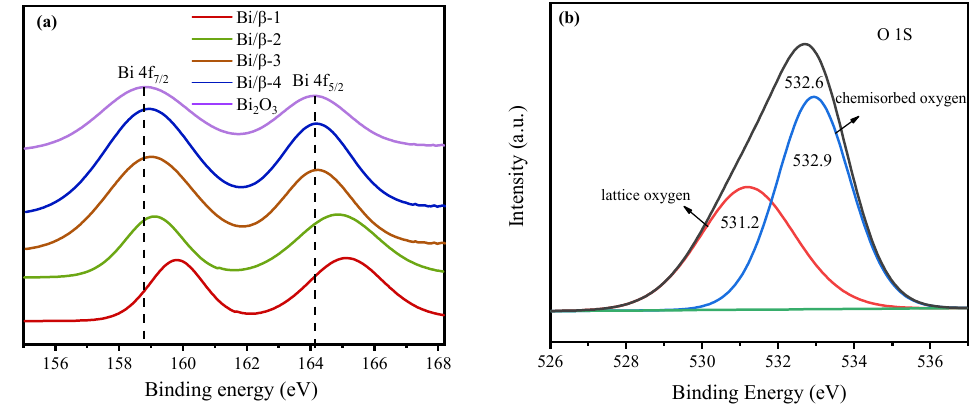
Figure 8. ( a ) Bi4f spectra of Bi/ β catalysts with different Bi loading, ( b ) O1s XPS spectra of Bi/ β -2.